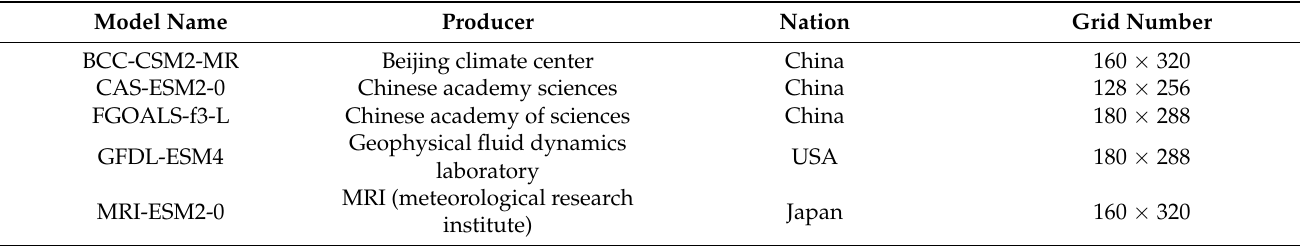
Table 3. List of global climate models of CMIP6 used in this